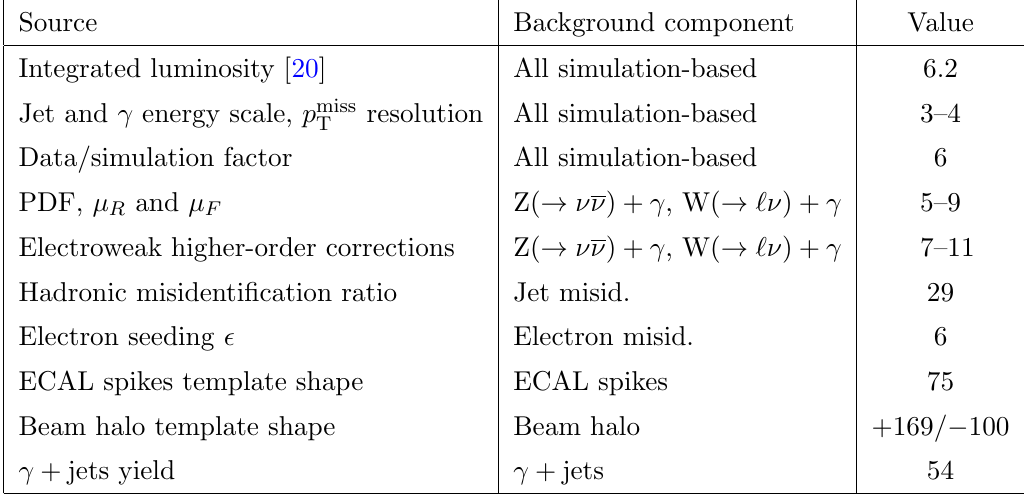
Table 2 . Summary of relative systematic uncertainties (%) for di(cid:11)erent background estimates. The middle column indicates the component of the estimated SM background that is a(cid:11)ected by each